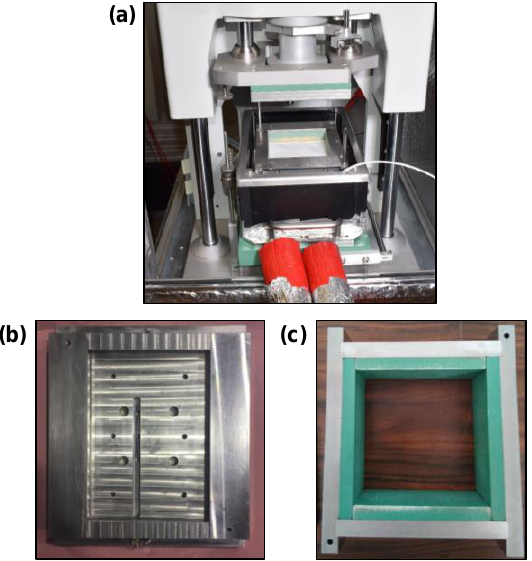
Figure 4. Interface direct shear apparatus: ( a ) loading frame, ( b ) bottom shear box and ( c ) upper shear box.